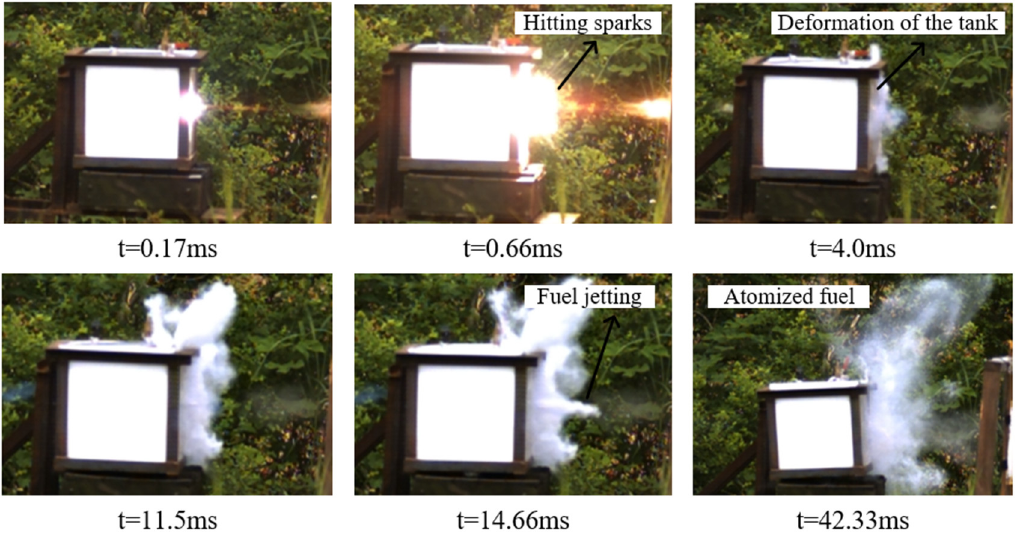
Figure 5. High-speed video frames of the fuel tank damaged by the 7 g steel fragments (v = 1868 m/s).